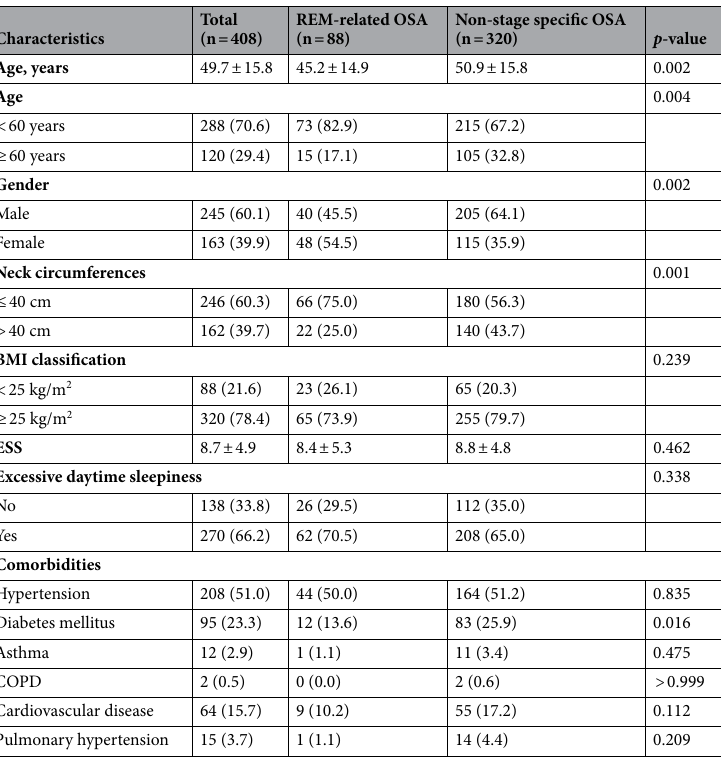
Table 1. Demographic, anthropometric, ESS, comorbidities characteristics of patients with REM-related OSA and non-stage specific OSA. Data are expressed as mean ± SD, or n (%). REM rapid eye movement, OSA obstructive sleep apnea, BMI body mass index, ESS Epworth Sleepiness Scale.